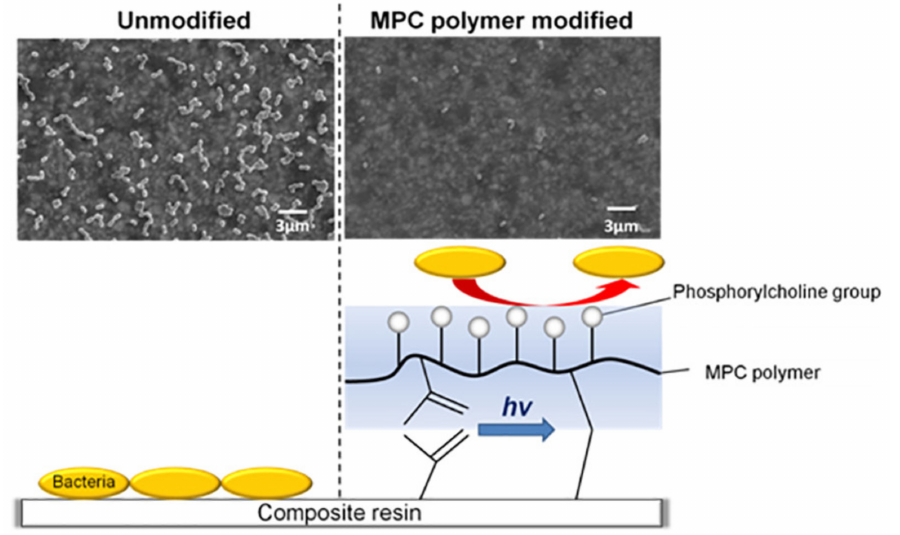
Figure 4. Schematic illustration of the use of 2-methacryloyloxyethyl phosphorylcholine (MPC) in resin composites. Adapted, with permission, from